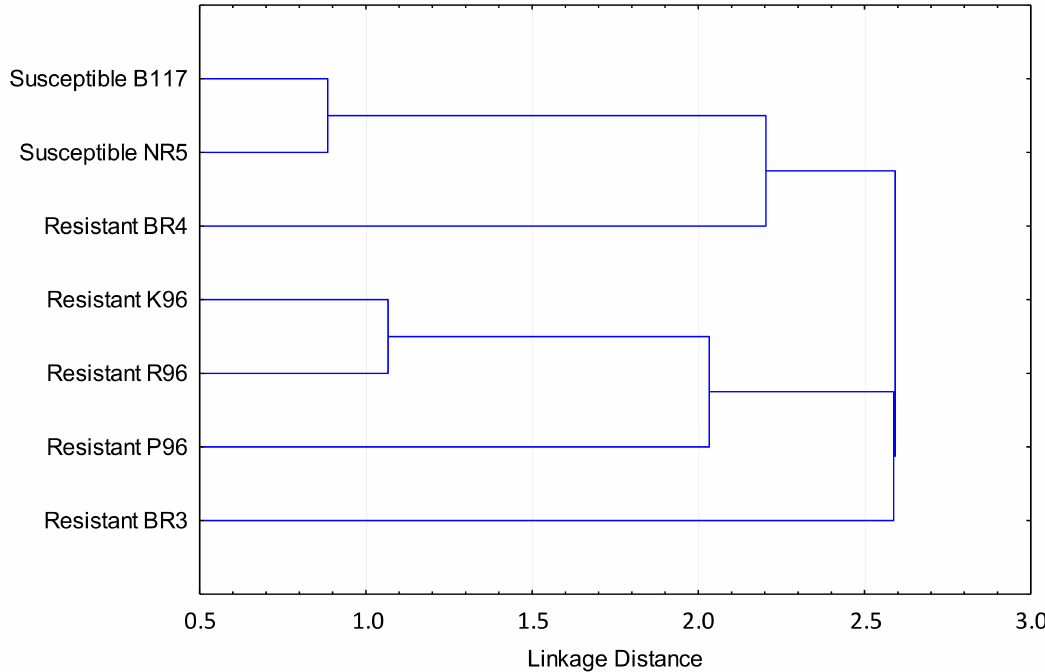
Figure 9. Cluster analysis for the sunflower varieties studied based on the concentration of costunolide, heliolactone, and